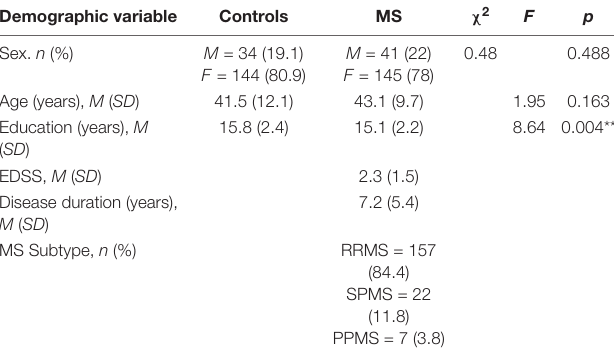
TABLE 1 | Demographic information and disease characteristics.